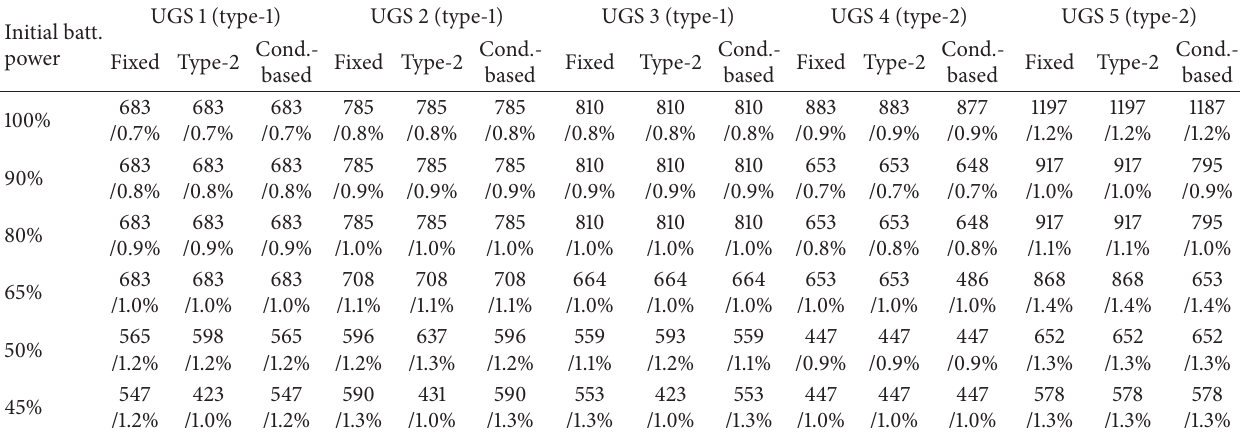
Table 6: Battery consumption (mA) for each UGS based on initial available power. Initial